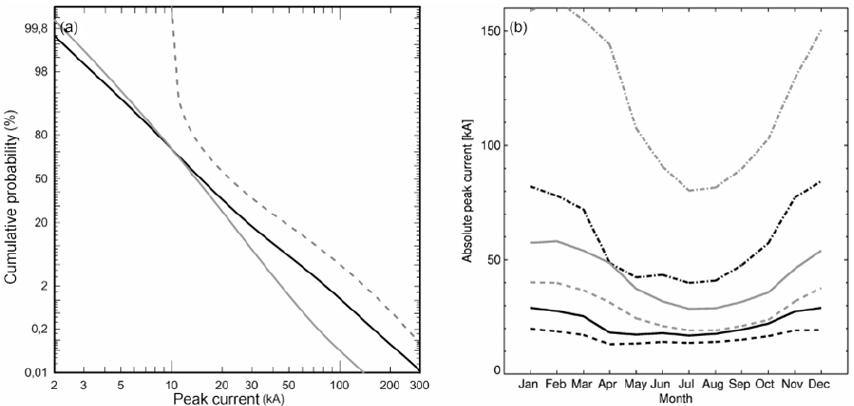
Figure 6. (a) Cumulative statistical distribution of return-stroke peak currents for negative first strokes (black solid), negative subsequent (grey solid), and positive first strokes (grey dashed). (b) Peak current distribution as a function of month for negative (black) mean (solid), median (dashed), 95th percentile (dashed–dotted) and for positive (grey) mean (solid), median (dashed), 95th percentile (dashed–dotted)